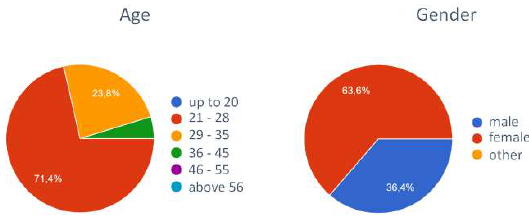
Figure 4: Age and gender distribution by participants.